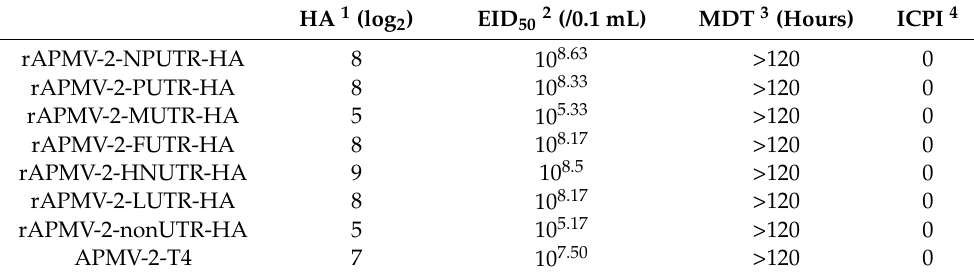
Table 2. Biological characteristics of rAPMV-2/HAs and APMV-2-T4.